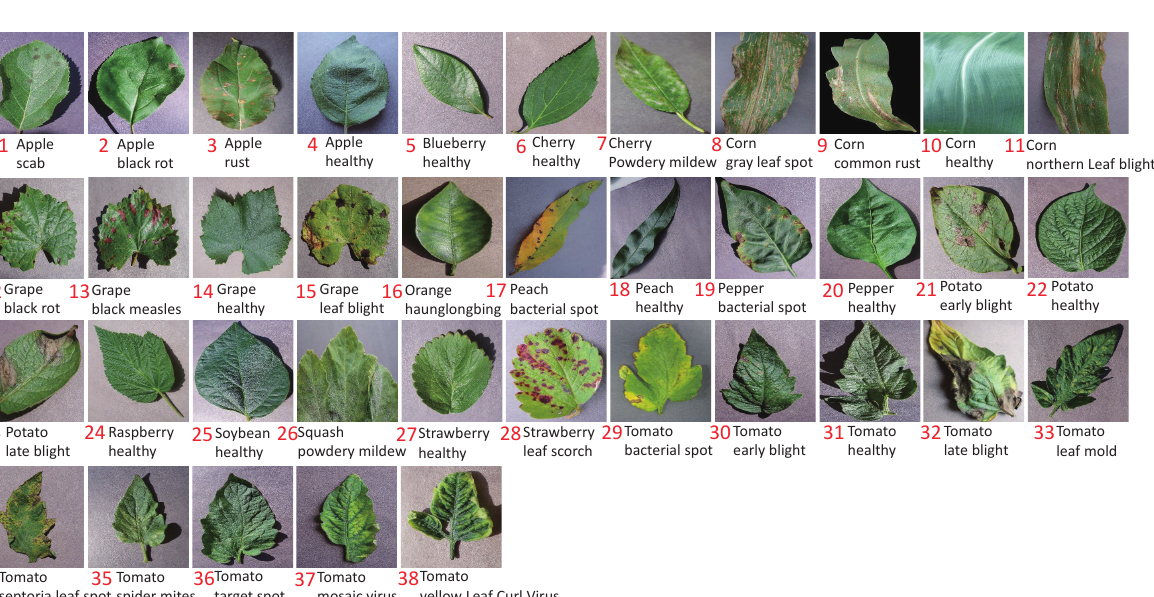
Figure 6. The samples of 38 categories in